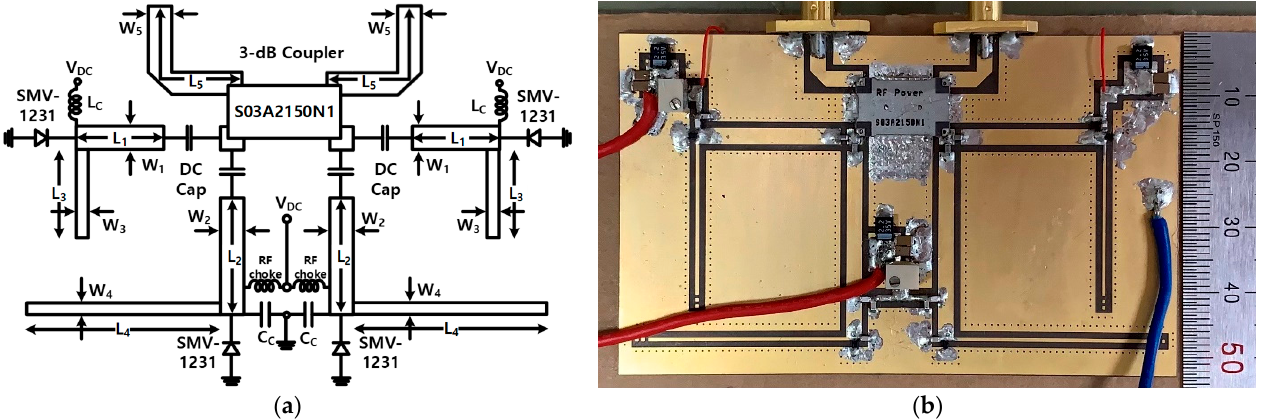
Figure 8. ( a ) Layout and ( b ) photograph of fabricated dual-band tunable reflection-type PS. Figure 8(a) defines the transmission line width, length, and components in the entire cir-